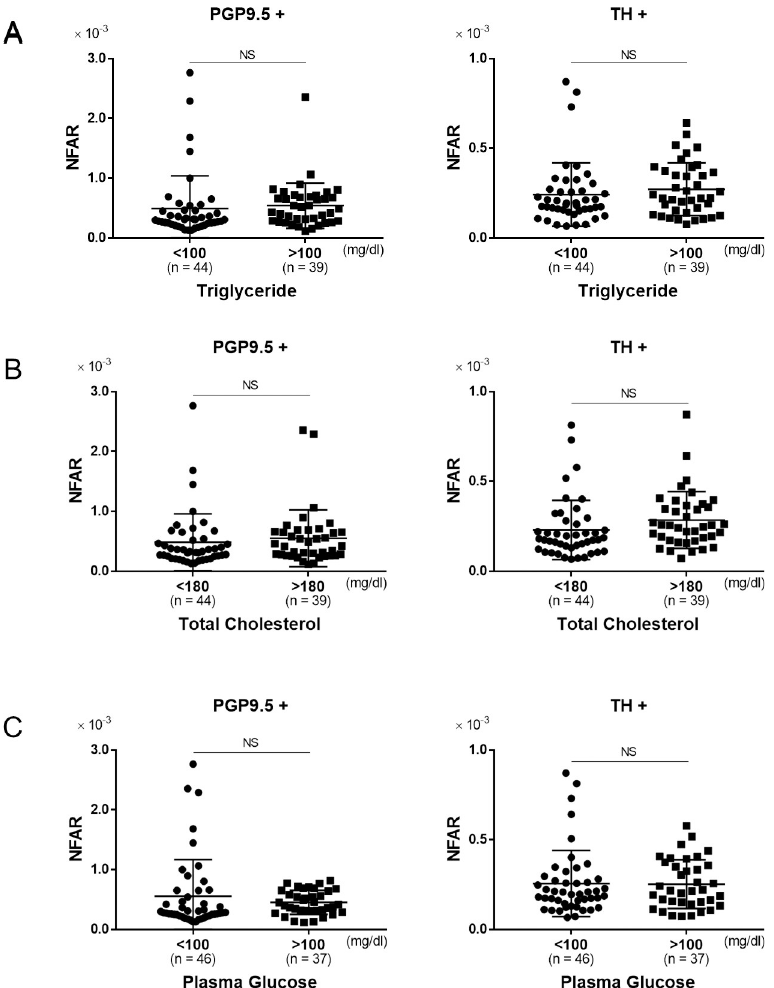
Fig 5. The relationship between metabolic parameters and NFAR. Comparison of NFAR for whole nerve fibers (PGP9.5+) and sympathetic nerve fibers (TH+). A: lower triglyceride level ( < 100 mg/dl) vs. higher triglyceride level ( � 100 mg/dl), B: lower total cholesterol level ( < 180 mg/dl) vs. higher total cholesterol level ( � 180 mg/dl), C: lower plasma glucose level ( < 100 mg/dl) vs. higher plasma glucose level ( � 100 mg/dl). Data were analyzed by unpaired t test. NS: not significant.